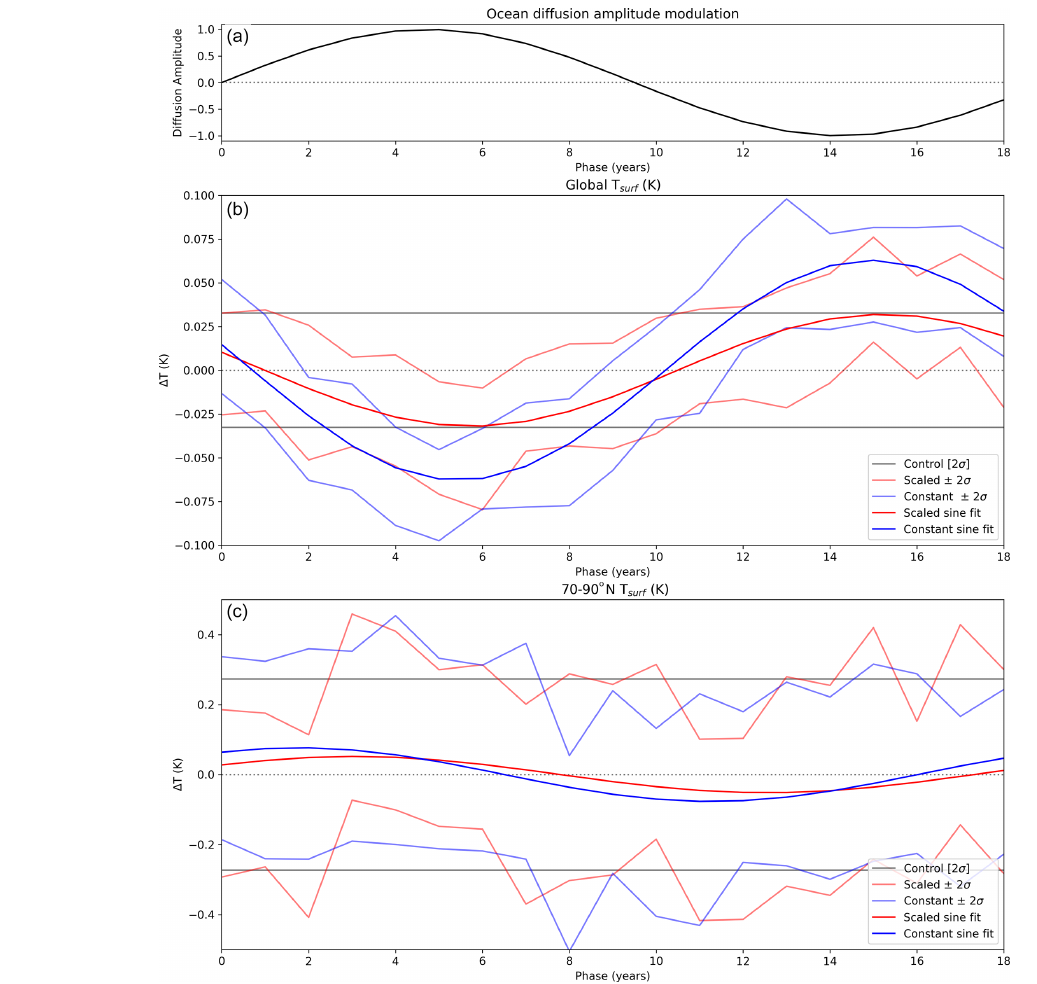
Figure 4. As Fig. 3 but for (b) globally averaged surface temperature T surf (K) vs. tidal modulation phase. (c) As for middle panel but for surface temperature (K) in the Arctic region (70–90 ◦